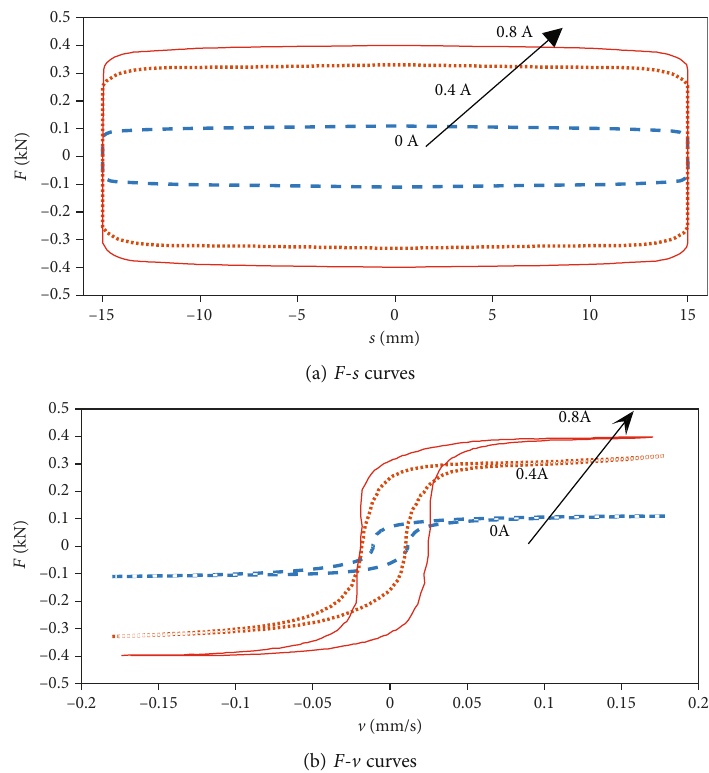
Figure 4: F - s curves and F - v curves of di ff erent current values under 2Hz and 15 mm